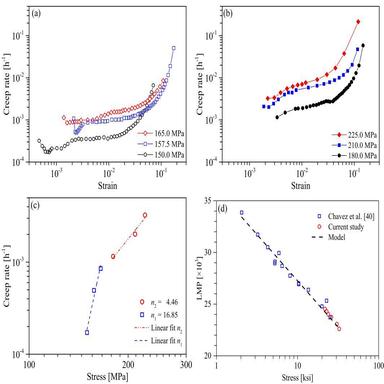
Creep rate for stresses of (a) 150 to 157.5 MPa, (b) n exponents for 180 to 225 MPa, and (d) Larson-Miller Parameter (LMP).